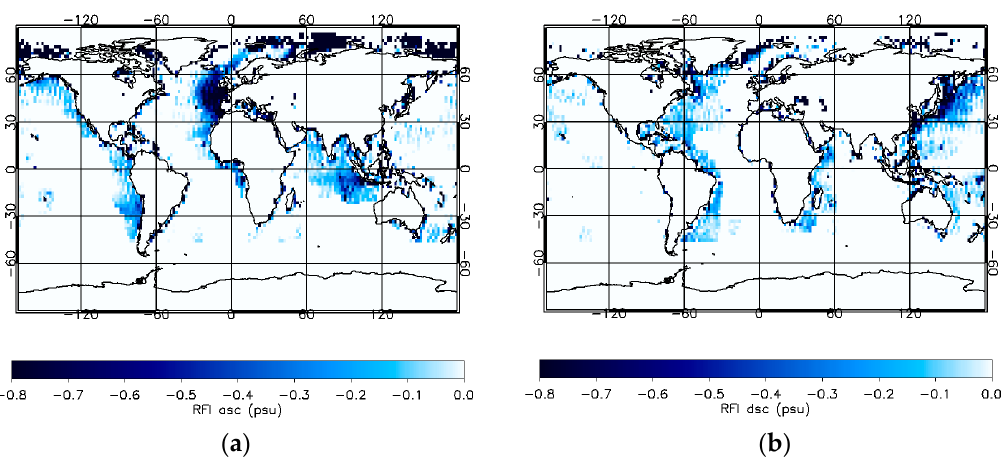
Figure 11. Estimated uncertainty in the retrieved Aquarius salinity due to undetected RFI for the ascending swath ( a ) and the descending swath ( b ). In producing the figures we have averaged over all 3 horns.